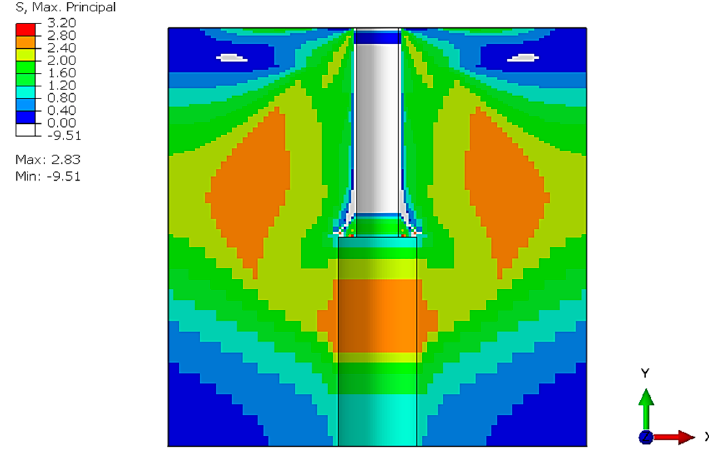
Figure 21. Map of maximum principal stresses for the POT-16 series.